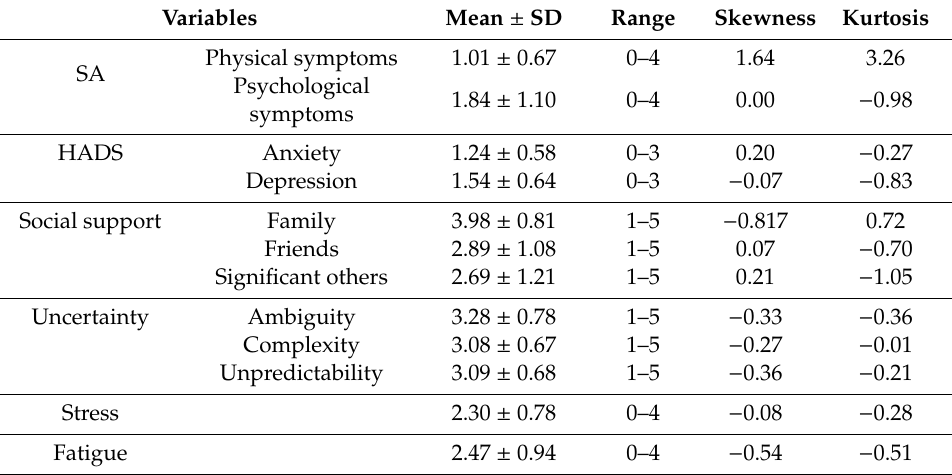
Table 2. Descriptive analysis of included